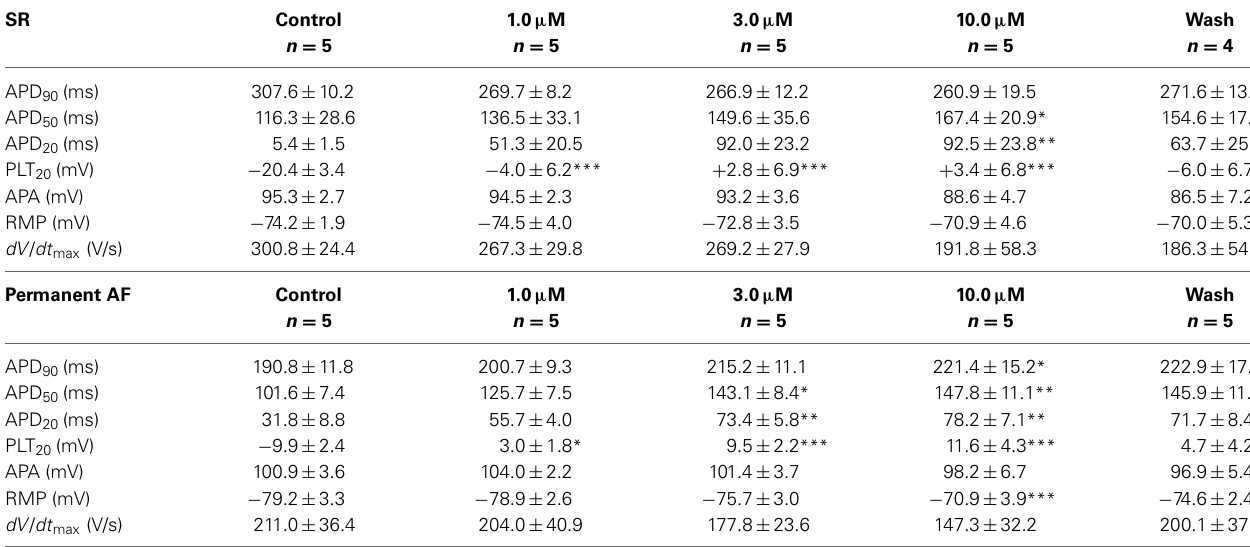
Table 2 | Concentration-dependent effects of MK-0448 at 1, 3, and 10 µ M (1Hz).